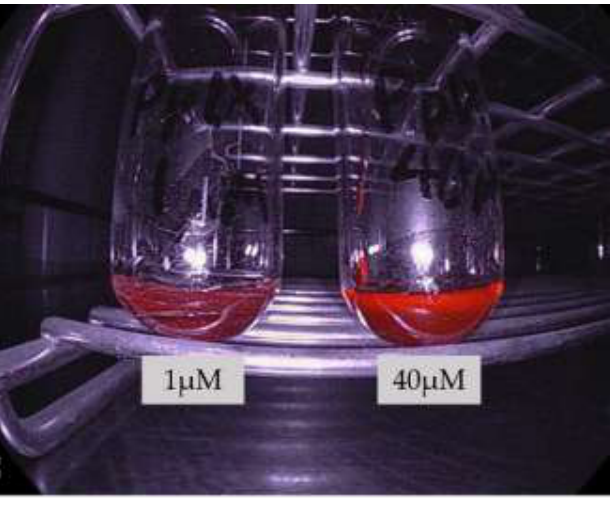
Figure 6. Image of PpIX irradiated with excitation light using ELUXEO equipped with an LED light source.